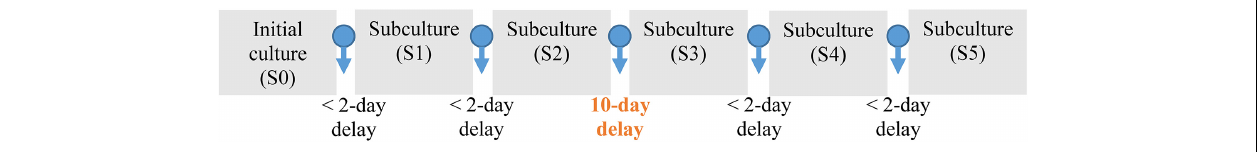
FIGURE 1 | Scheme of the successive subculturing procedure applied on 2.2 L-STR in batch conditions. Each culture contained 3Cm medium and 2% (w/v) PCBs.